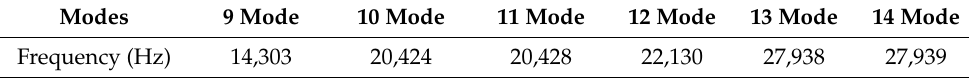
Table 3. The modal analysis results of ultrasonic horn.